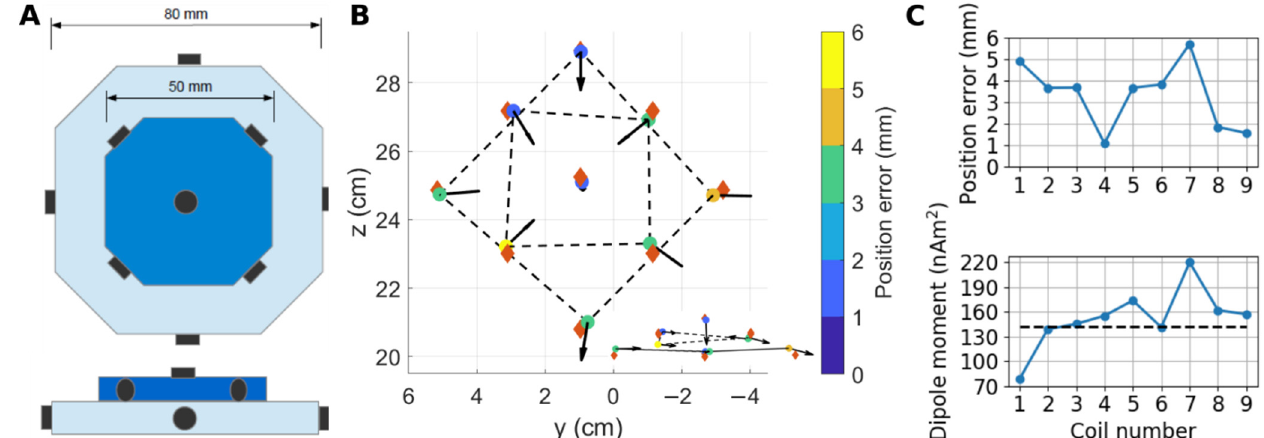
Figure 6. Localization of magnetic dipoles in a phantom using the calibrated 48-channel OPM array: ( A ) A drawing of the 3D-printed phantom showing the locations and orientations of the small circular coils approximating magnetic dipoles (shown black). Both top and side views of the phantom are shown. ( B ) The estimated dipole positions (circles) and orientations of the coil dipole moments (black arrows). Red diamonds show the positions of the coils according to the CAD model of the phantom. The circles are color-coded according to the distance between the estimated position and that of the CAD model. Inset gives a side view of the dipoles. ( C ) The dipole position errors between the CAD model and the estimates, as well as the estimated dipole moments of the coils. The dashed horizontal line shows the dipole moment estimated from the current by which the coils were driven.